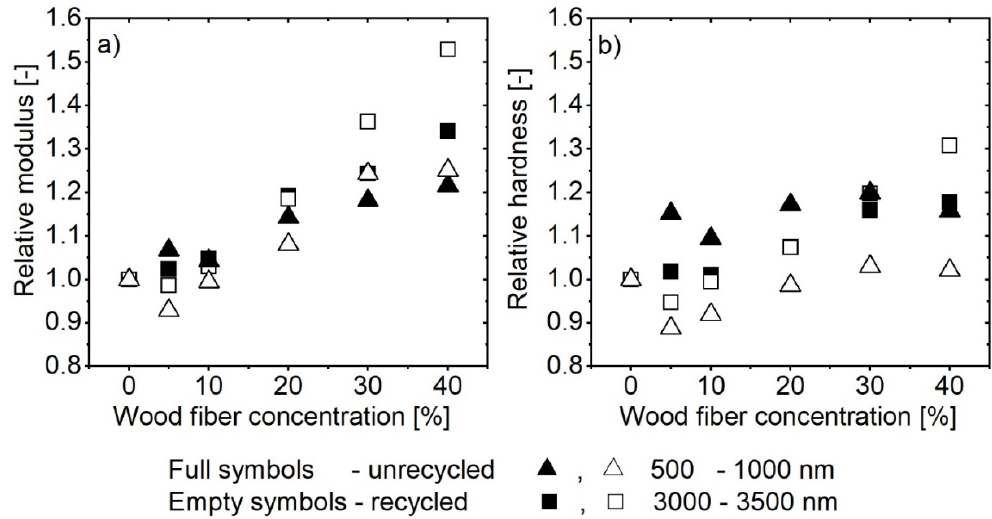
Figure 15. Normalized nanoindentation ( a ) modulus and ( b ) hardness at two selected nanoindentation depths for unrecycled and recycled material as a function of WF concentration.